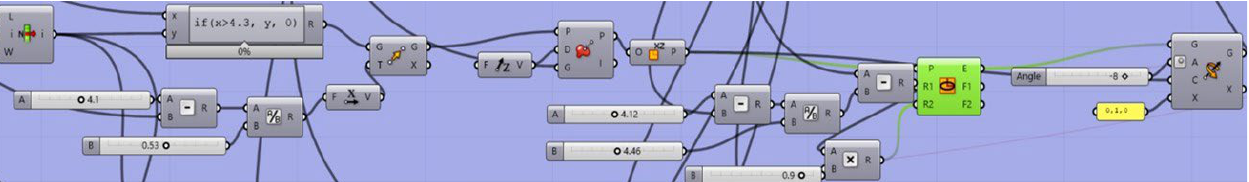
Figure 13. Boolean test in visual script to create additional voids if h m (cid:48) is larger than 4 m (Equation (14)). The horizontal radius